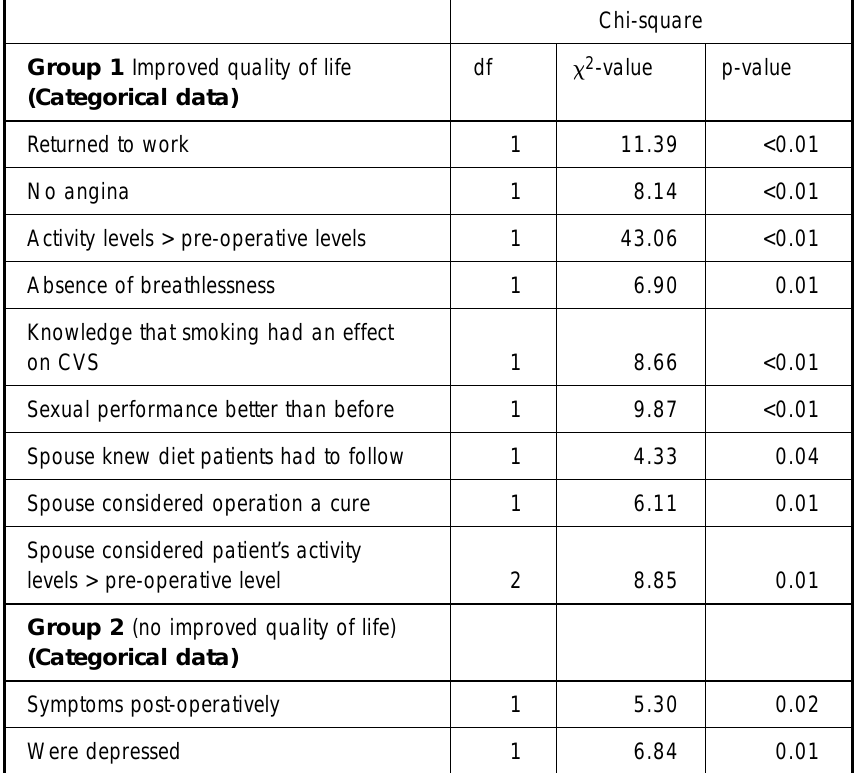
Table V: Twelve Months after